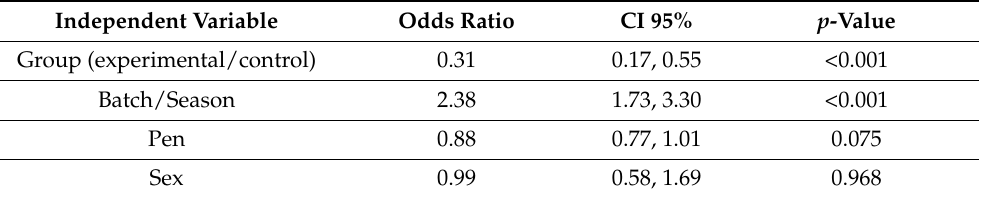
Table 4. Odds ratios and 95% Confidence Interval (CI) for the associations between the incidence of tail injuries and independent variables of the multiple logistic regression